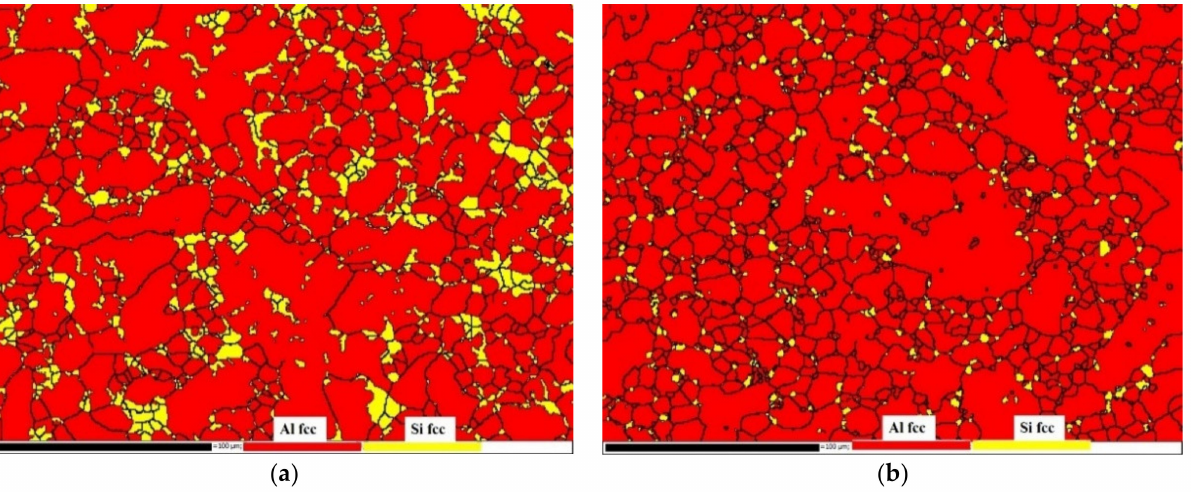
Figure 4. EBSD maps of non-heat-treated, die-cast samples: ( a ) before heat treatment; ( b ) after heat